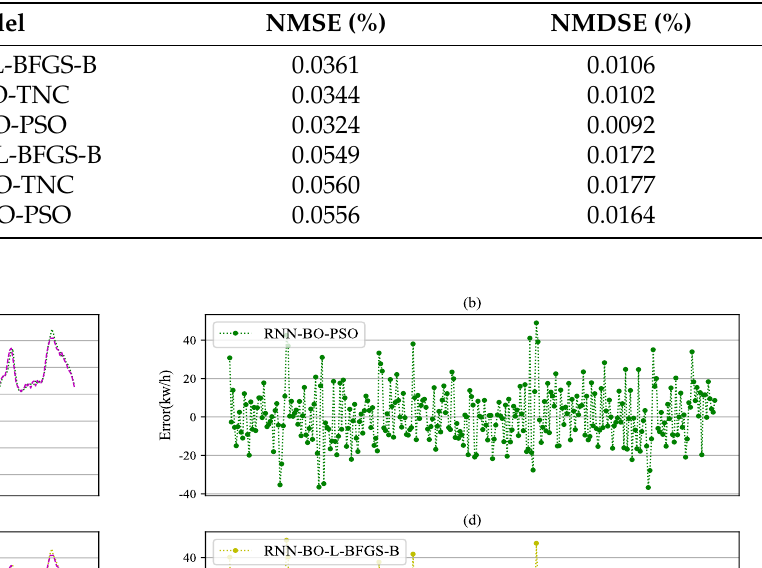
Table 4. Error of the prediction result in different models.